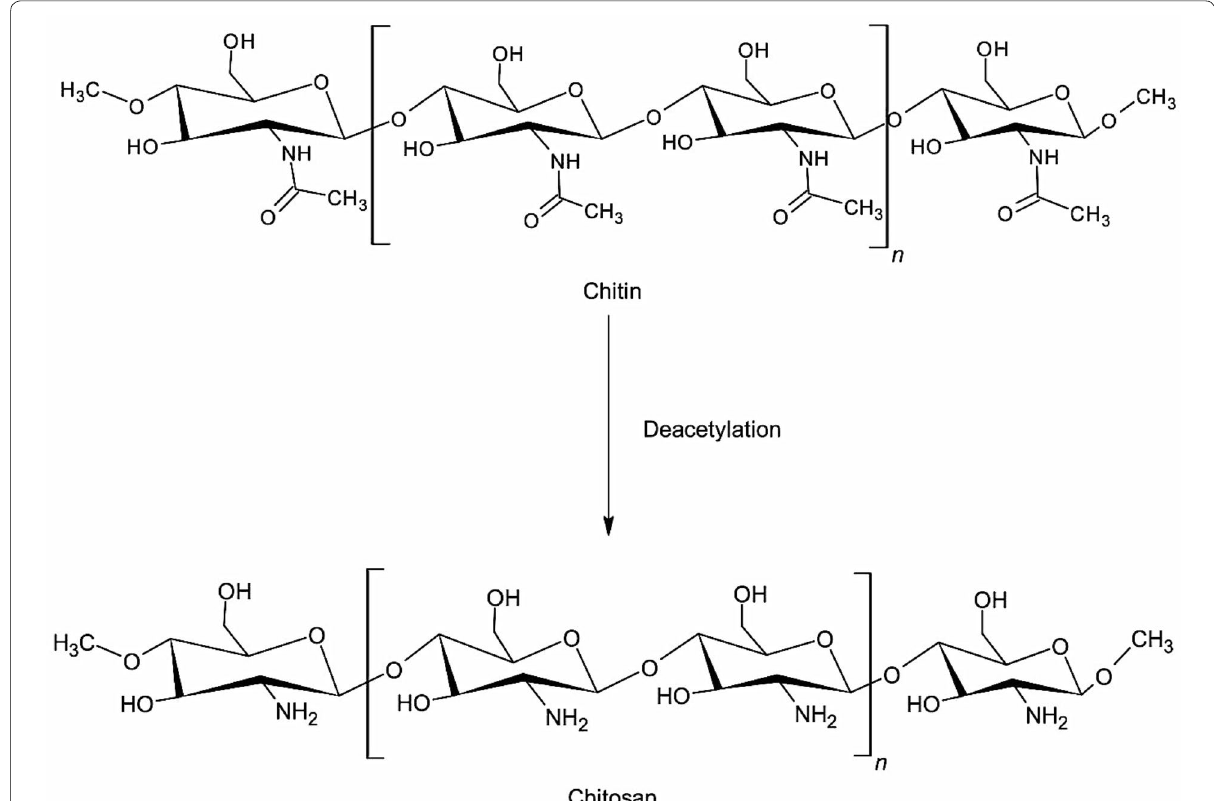
Fig. 3 Chemical structures of chitin and